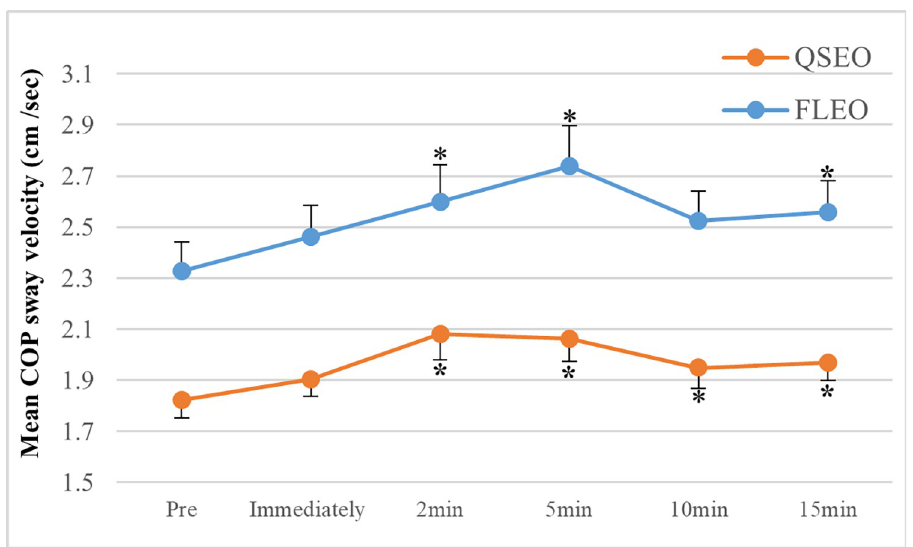
Fig 3. Mean COP sway velocity. Mean COP velocity shown before and immediately following exercise, and throughout the recovery period (2, 5, 10, and 15 min) for quiet standing (QS) and standing forward leaning (FL) tasks with eye open (EO). � = significant fatigue effects ( p � 0. 05, compared to pre-exercise) on sway velocity.